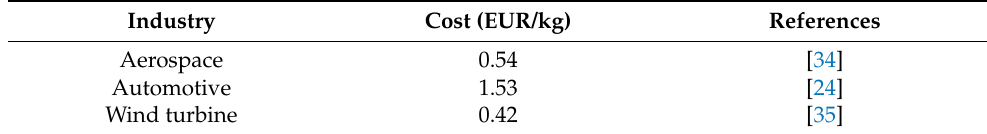
Table 2. Dismantling cost in different industries. Industry Cost